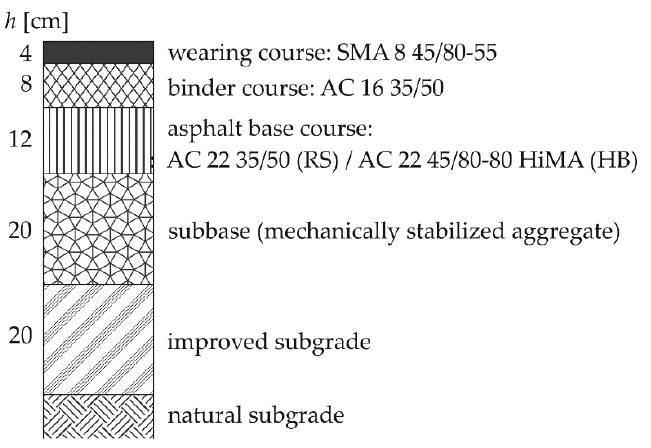
Figure 1. Pavement structure for analysis.